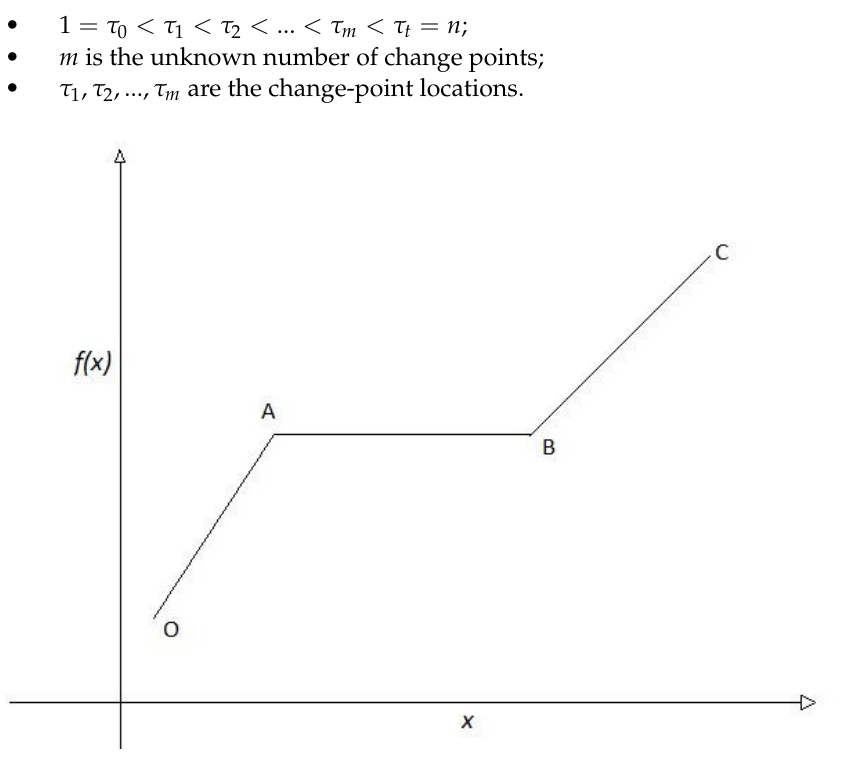
Figure 3. Simple change-point